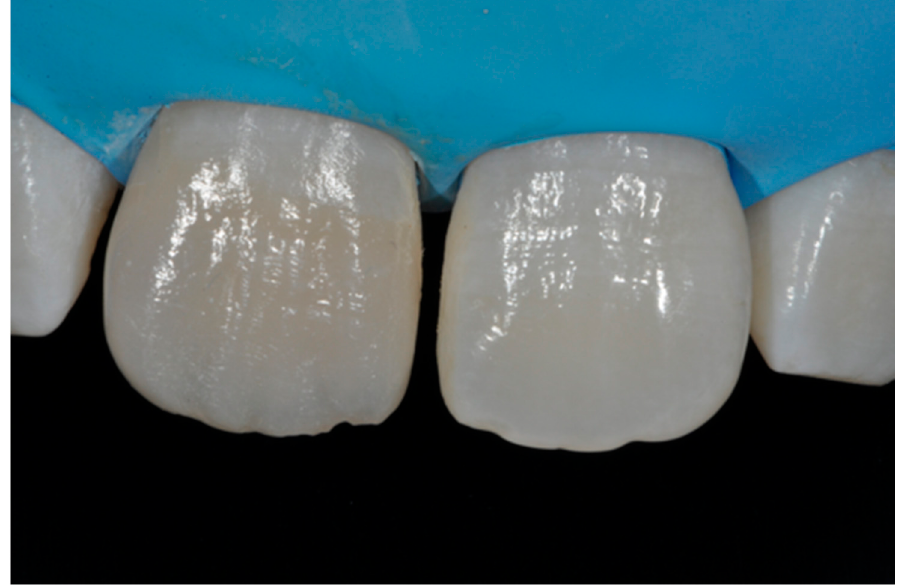
Figure 14. After vertical and horizontal anatomy definition and final polishing. Reprinted from Restauri diretti nei settori anteriori, G. Paolone, S. Scolavino, © 2021, with permission from Quintessence Publishing Italy.